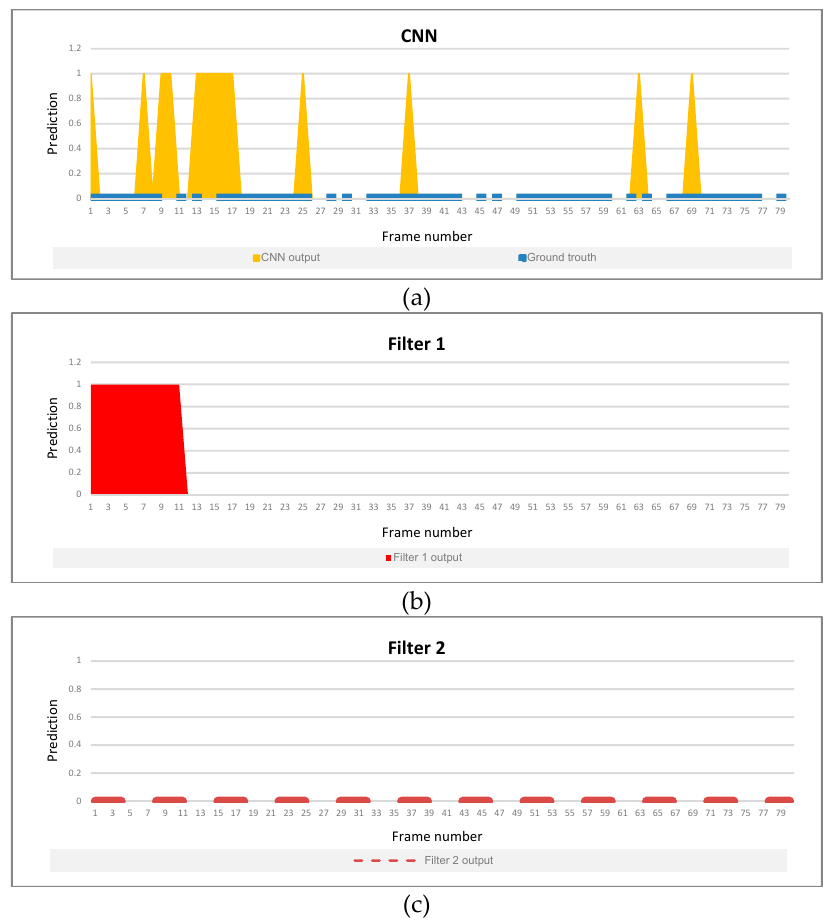
Figure 7. Output collected on di ff erent stages. ( a ) CNN prediction. ( b ) Filter 1 prediction. ( c ) Filter 2 prediction.